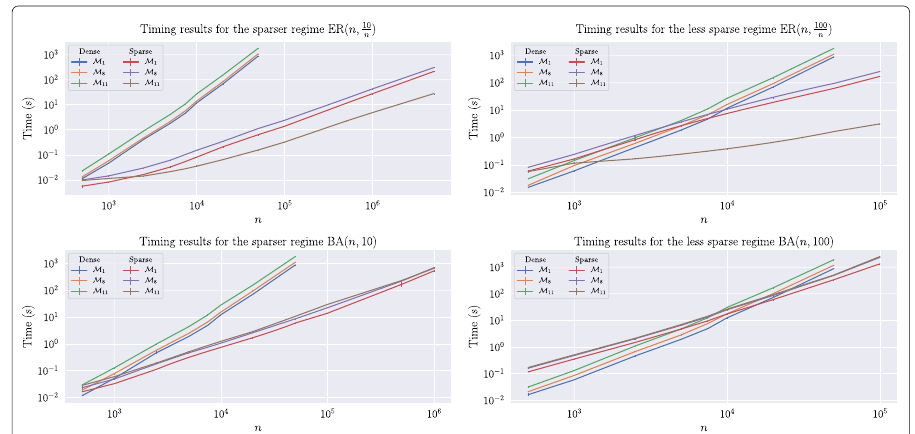
Fig. 4 Run time for our two approaches. Top: Erd˝os-Rényi (ER) graph ensembles. Bottom: Barabási-Albert , BA: m = 10) and the right panels (BA) graph ensembles. The left panels show very sparse graphs (ER: p = 10 n , BA: m = 100). We average over five repeats, and error bars are one show less sparse graphs (ER: p = 100 n sample standard